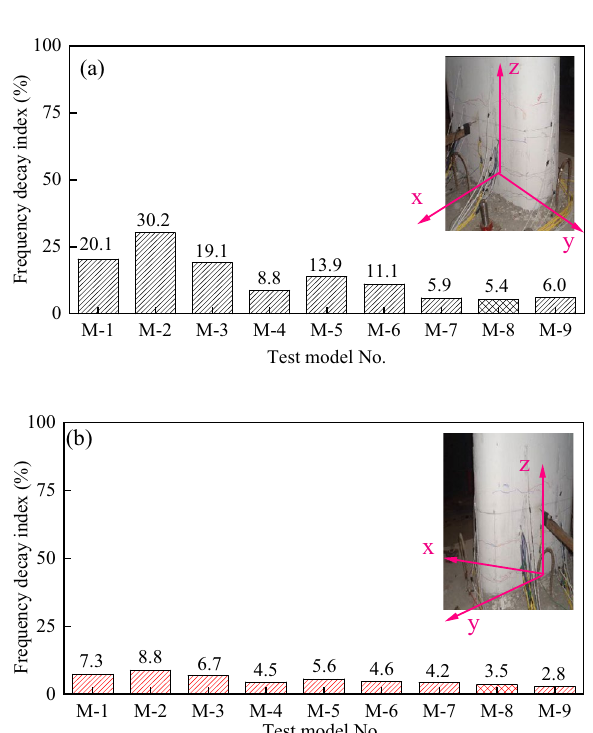
Figure 12. Attenuation of the fundamental frequency of post-earthquake pier specimens. ( a ) x-direction, ( b )